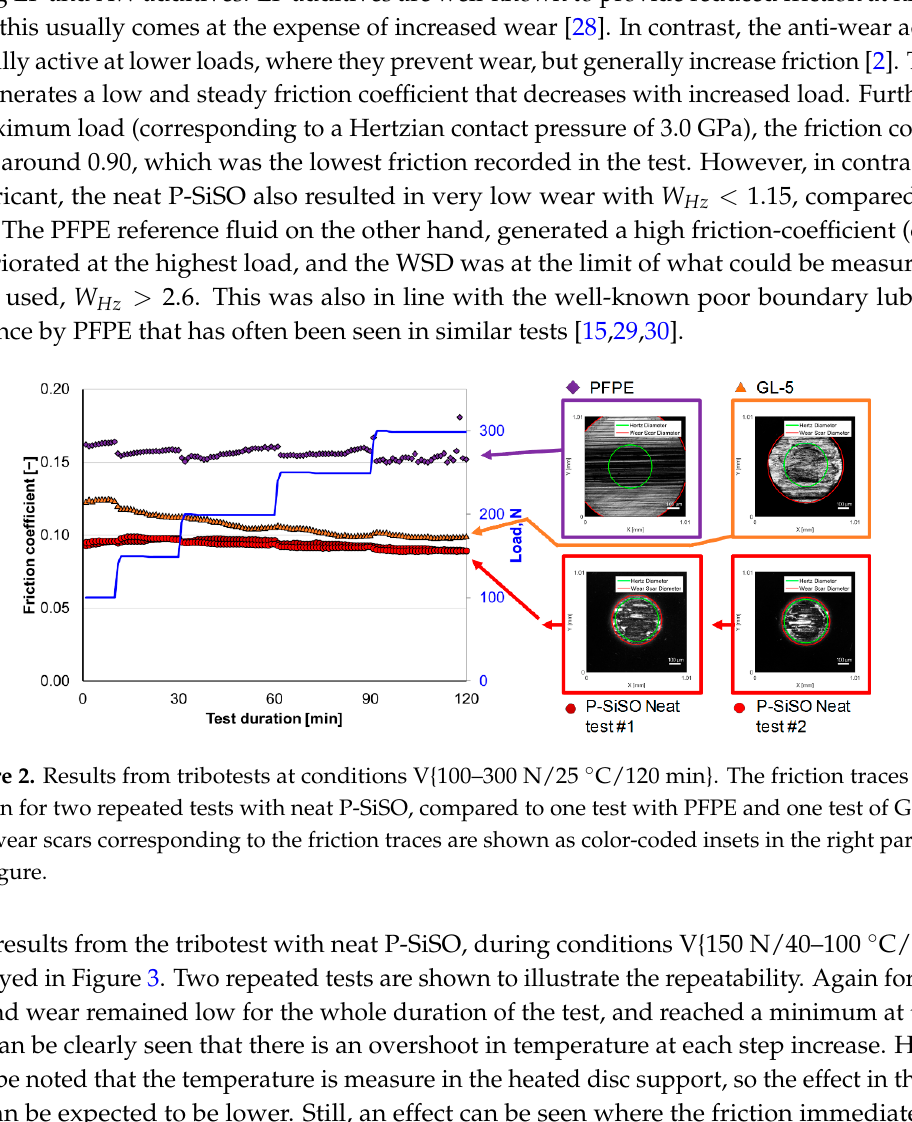
Figure 3. Results of V{150 N/40–100 °C/80 min} for two repeated tests with neat P-SiSO. Ball wear scars are shown as insets to the right.